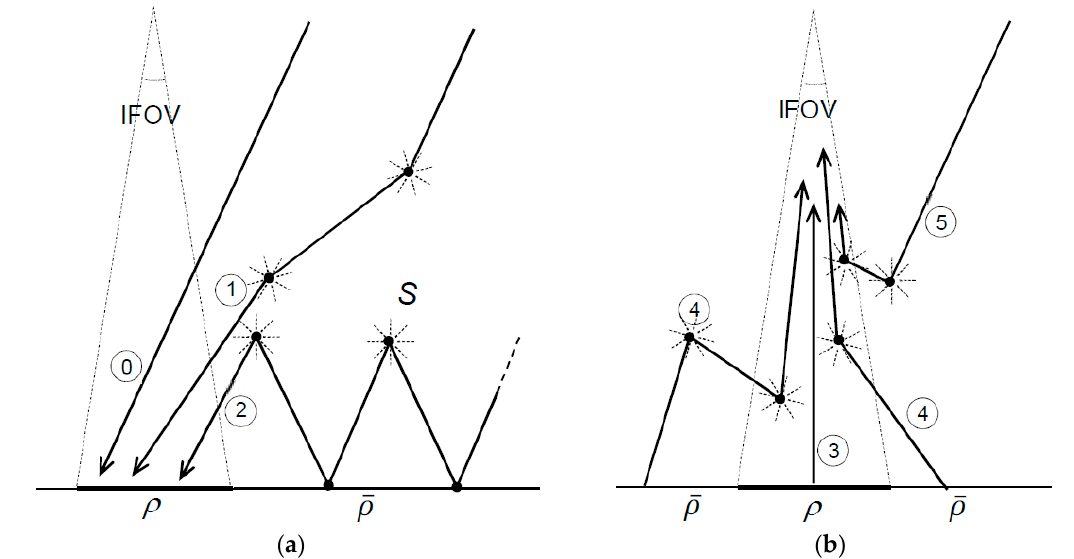
Figure 1. ( a ) Contributions to the irradiance impinging on the generic ground pixel (with reflectance ρ ) subtended by the IFOV of the corresponding image pixel: (0) direct Sun-to-pixel, (1) diffuse (impinging on the pixel after one or more scattering events, but without interaction with ground), (2) trapped between ground (with average reflectance ρ ) and overlaying atmosphere (with albedo S). ( b ) Contributions to the radiation received into the generic IFOV: (3) directly from the corresponding ground pixel without scattering events, (4) from neighbouring pixels via diffuse radiation, and (5) path radiance non-interacting with